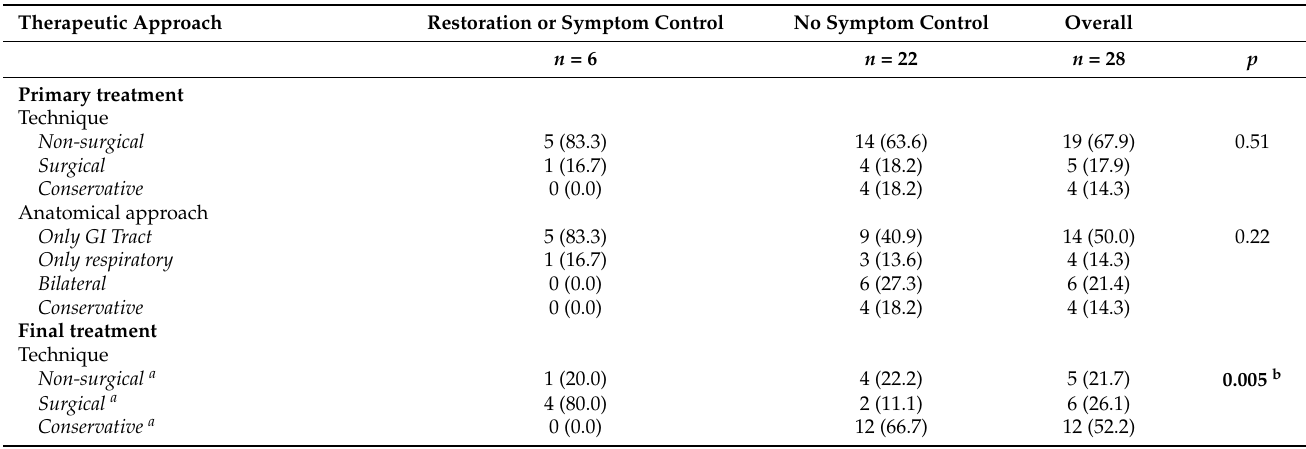
Table 4. Therapeutic management and clinical outcome of